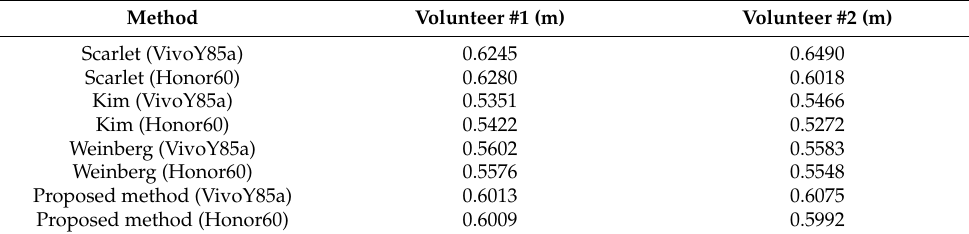
Table 3. Step length estimation with Honor60, VivoY85a, and two different height pedestrians in the second scene.